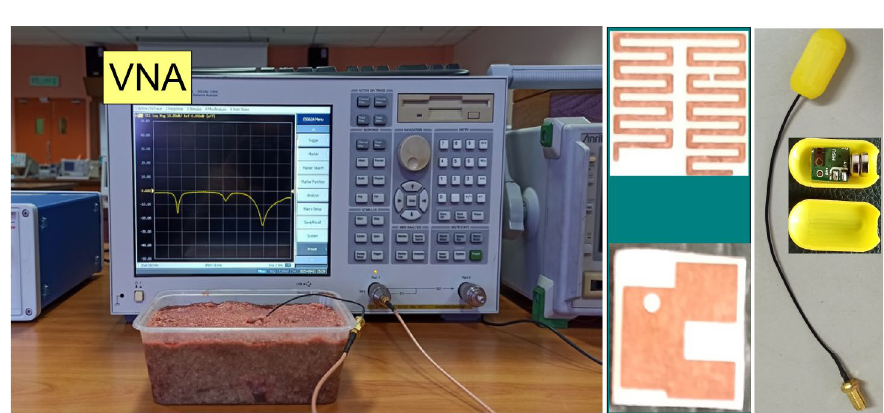
Figure 10. Reflection coefficient measurement setup of the proposed